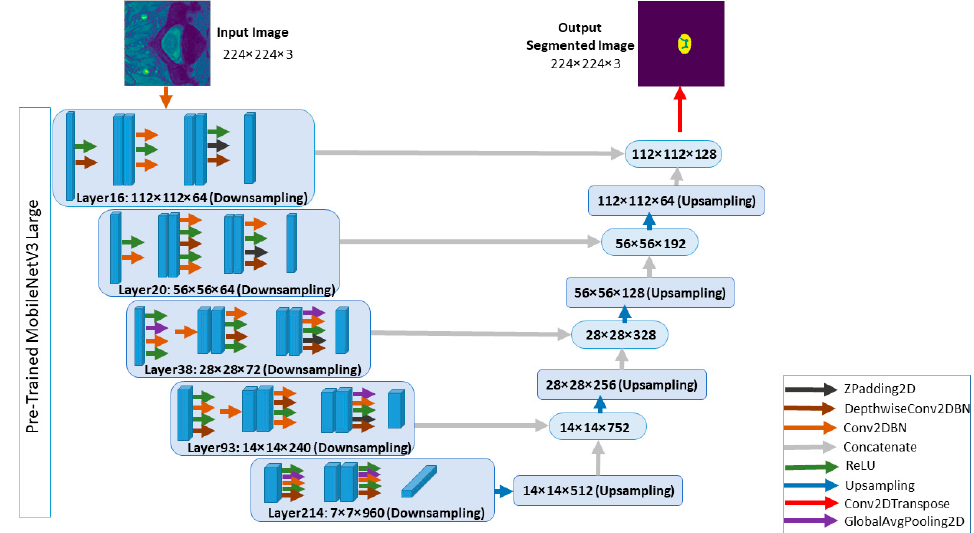
Figure 9. Architecture of the proposed MobileUNetV3 deep learning model.